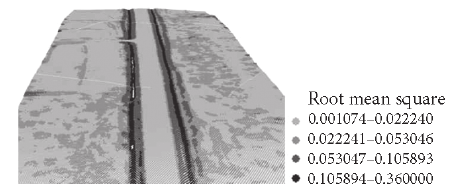
Fig. 3. Rms of plane fitting in the vicinity of the points located at a distance of 1.5 m